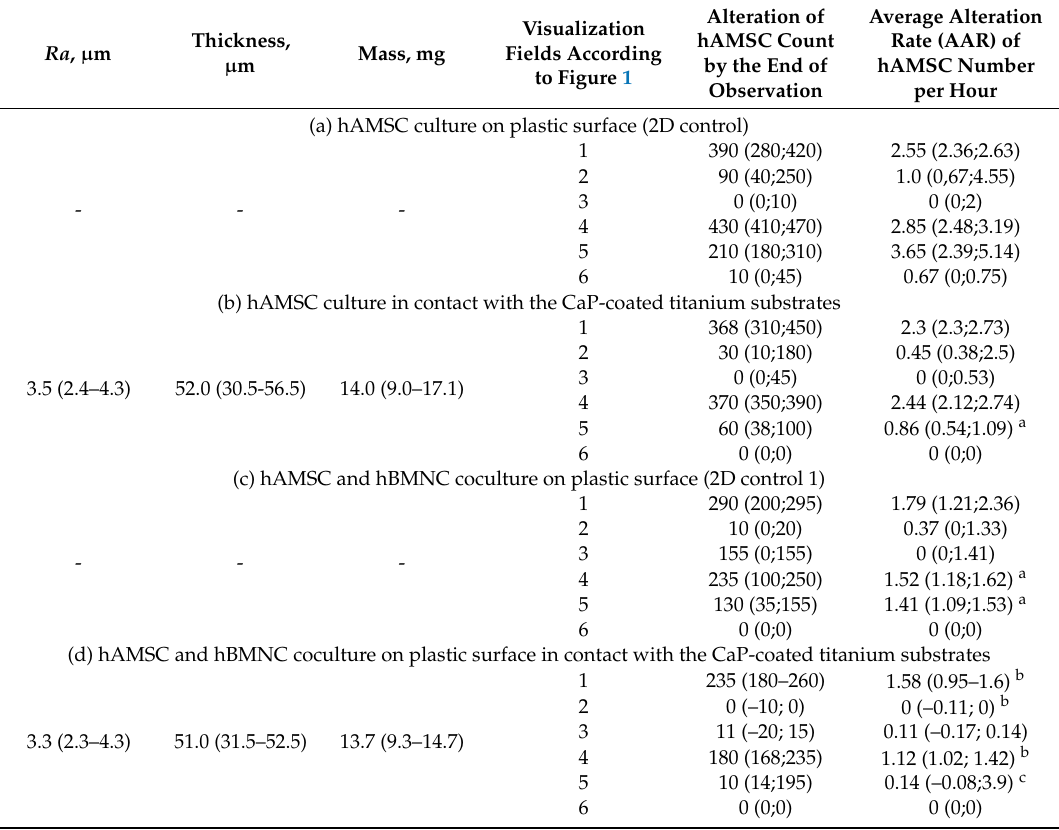
Table 4. Monitoring hAMSC motility during 7 days of culture without or with hBMNCs and / or the rough CaP coating, Me (Q1; Q3), n =